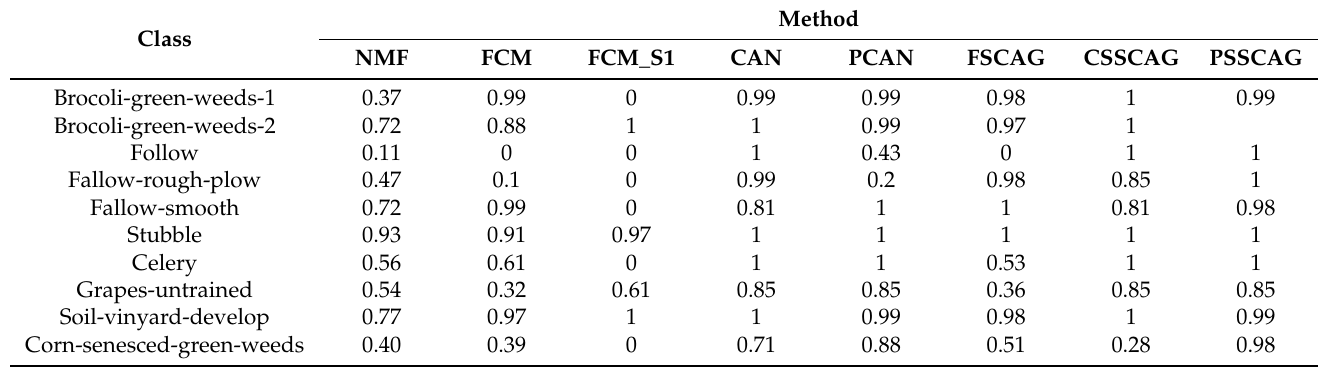
Table 3. Clustering accuracy of each category, OA, NMI, and κ of different clustering methods on Salinas